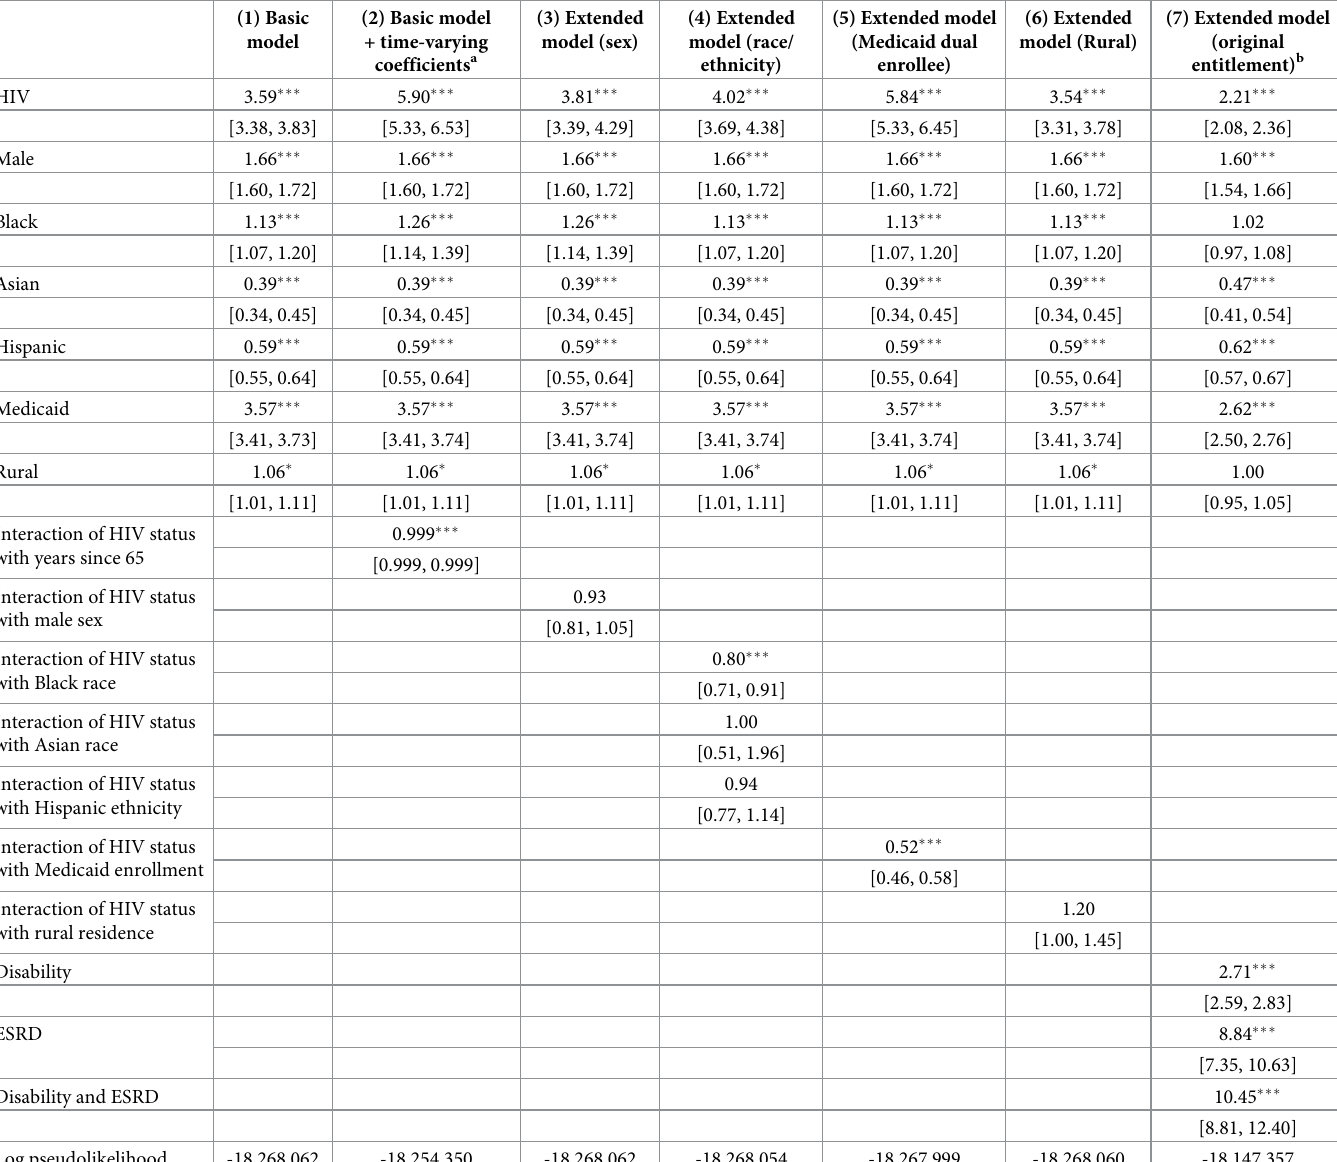
Table 2. Cox proportional model, hazard ratios reported (Medicare beneficiaries observed at age 65 between